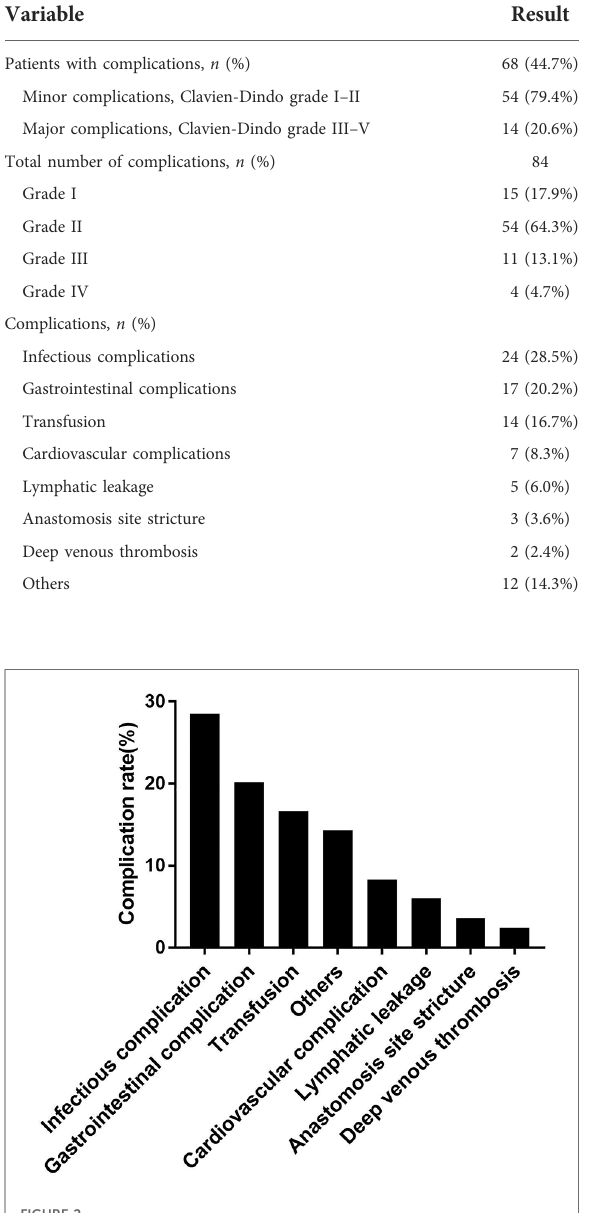
TABLE 3 Univariate analysis of overall postoperative complications after